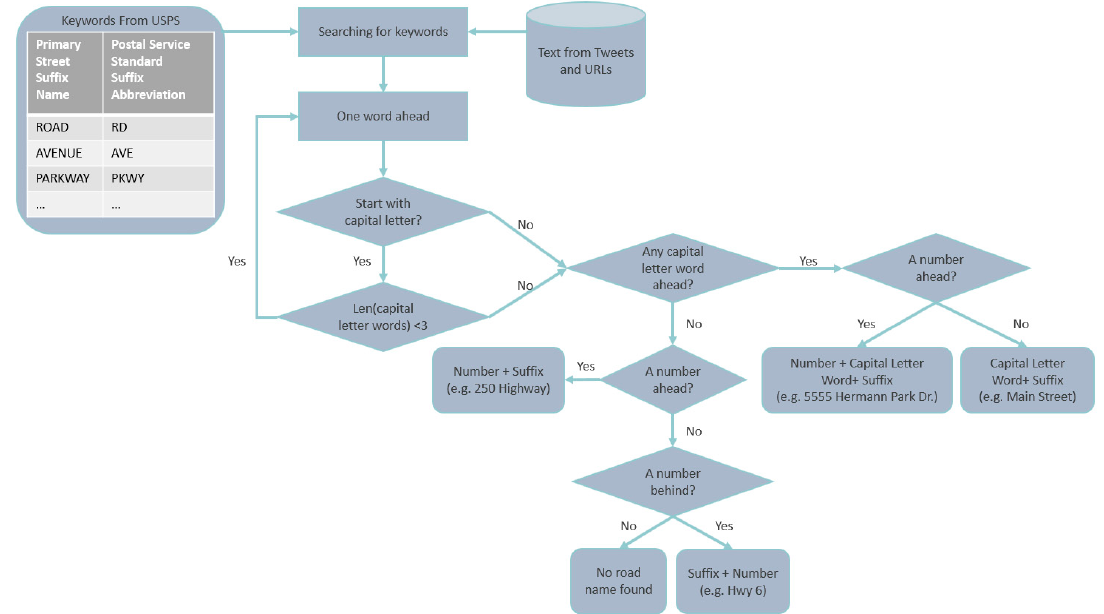
Figure 2. Procedure for extracting road names from text. Possible road name compositions are as follows: 1. Number + Suffix; 2. Number + Capital Letter Words + Suffix; 3. Capital Letter Words + Suffix; and 4. Suffix + Number.